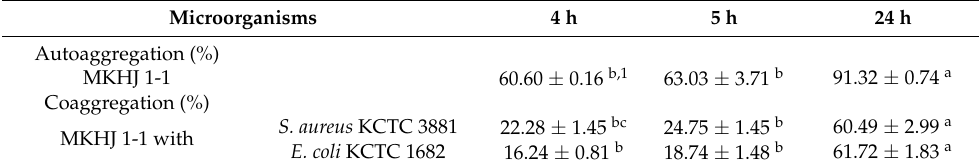
Table 5. Autoaggregation and coaggregation ability of MKHJ